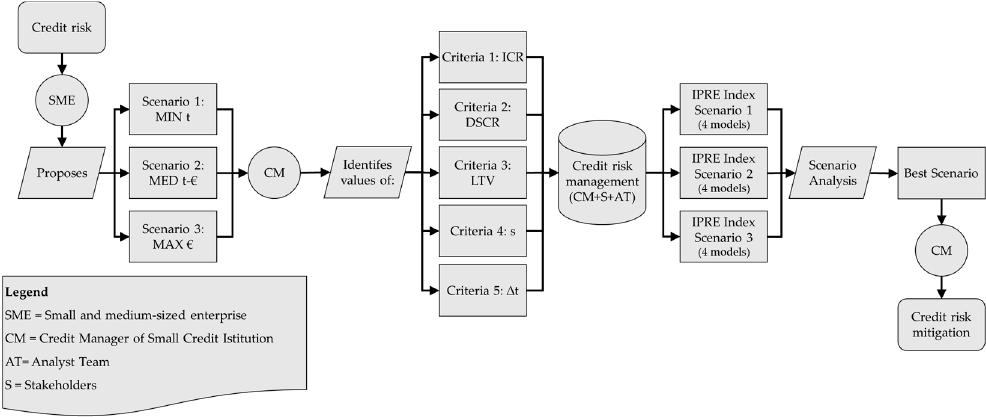
Figure 5. Flowchart of the credit risk mitigation process applied to the present case study.